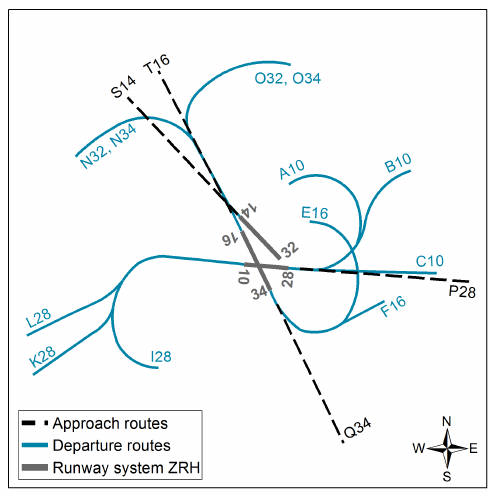
Figure 2. Overview of the runway system and air routes at Zürich Airport